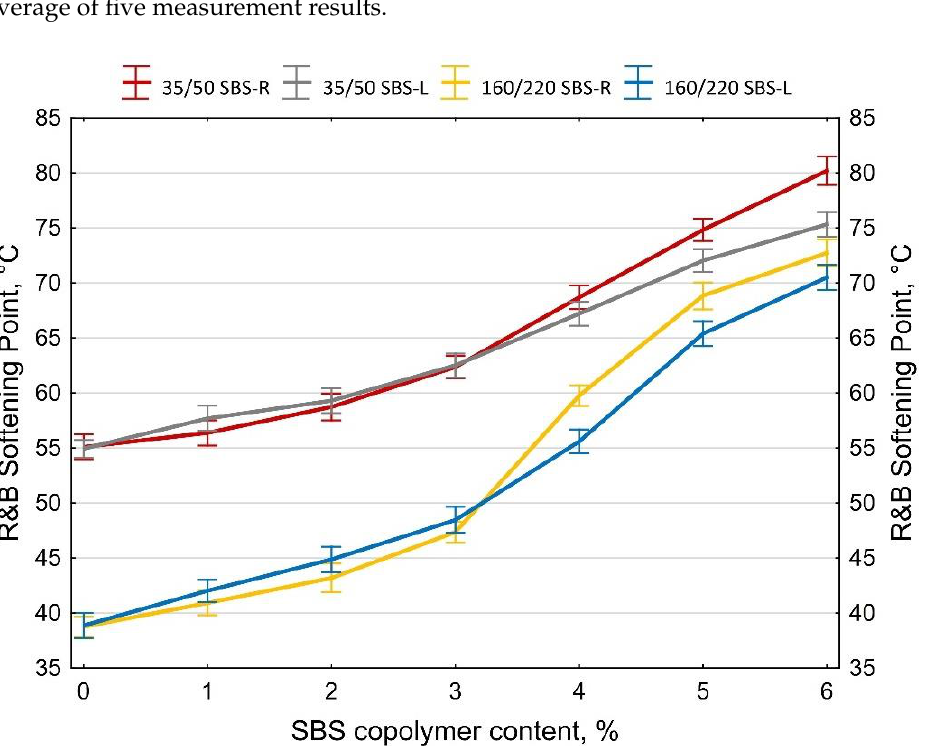
Figure 8. Penetration at 25 °C of SBS-modified bitumens, error bars show a 95% confidence inter- val for the mean.